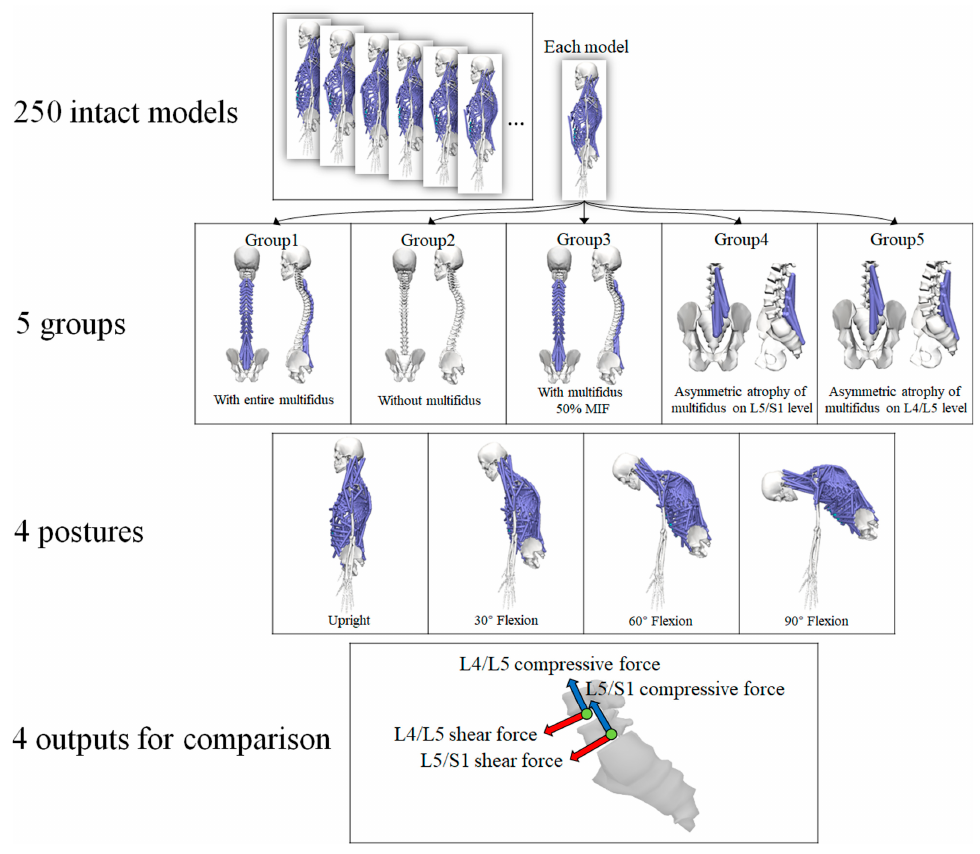
Figure 1. The scenarios for simulation (MIF, maximum isometric force).